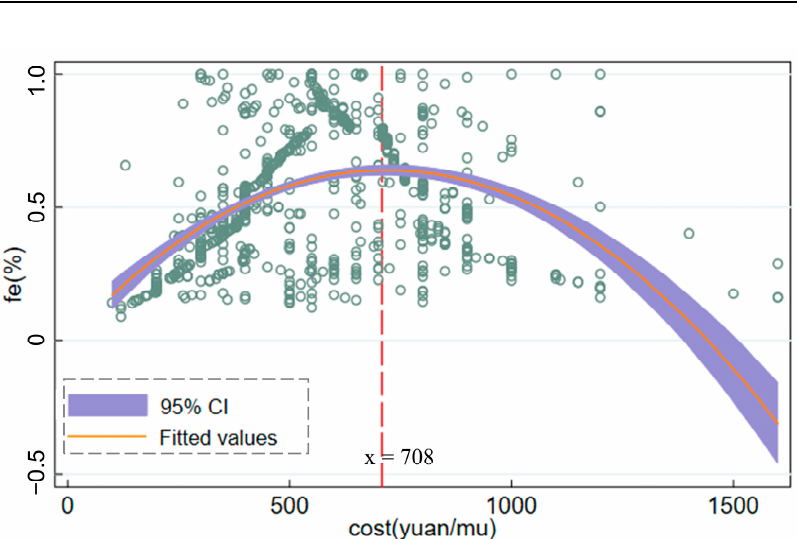
Figure 4. The inverse “U” shape relationship between cost and fe.